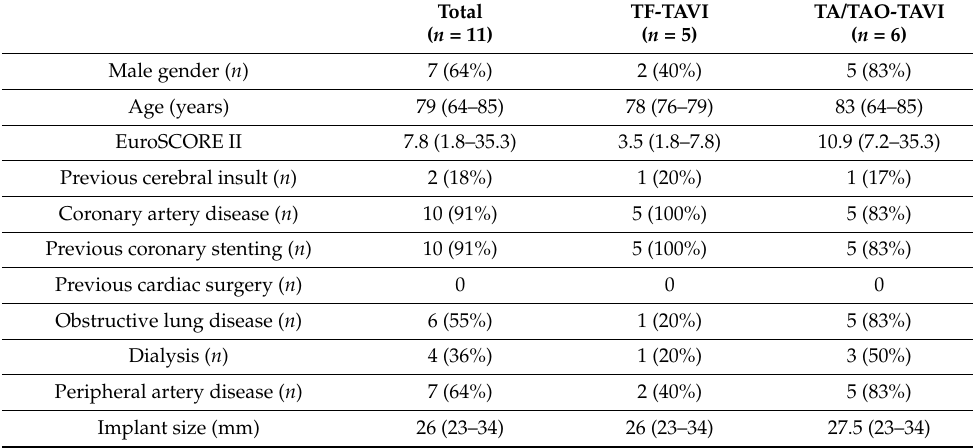
Table 1. Preoperative